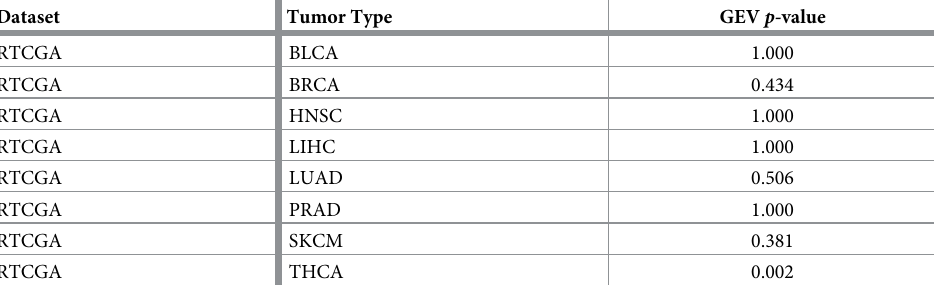
Table 3. The χ 2 goodness-of-fit test p -values of the RTCGA dataset with tumor-type-specific symbol -based filter- ing (rank <